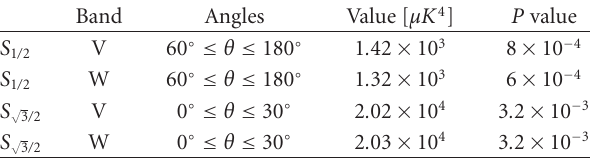
Table 8: S statistics of WMAP 7 year data. Table 9: The S statistics of WMAP instrument noise in the unit of ( μK 4